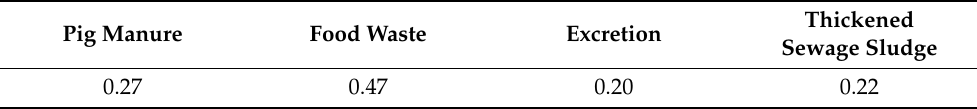
Table 3. Target methane production rates (Nm 3 CH 4 /kg